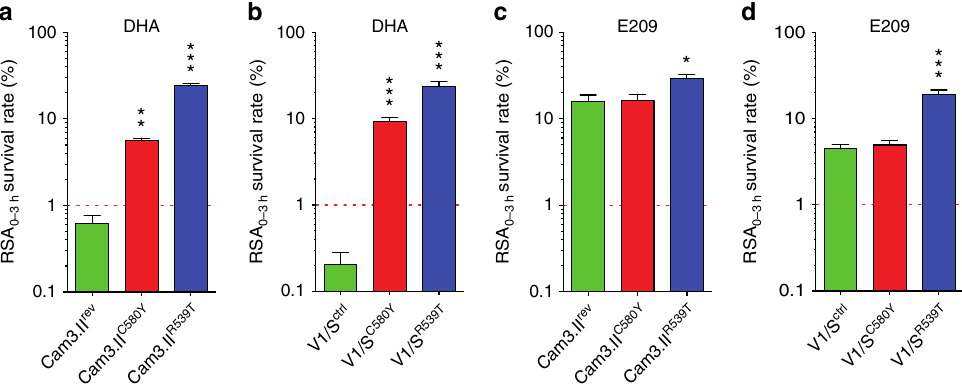
Figure 3 | Ring-stage survival assays show equal potency of E209 against K13 wild-type and C580Y mutant parasites whereas R539T confers a marginal increase of survival. Results show the percentage of early ring-stage parasites (0–3h post-invasion of human erythrocytes) that survived a 6-h pulse of 700nM DHA or E209, as measured by flow cytometry 90hours later. Data show mean ± s.e.m. percentage survival compared to DMSO-treated parasites processed in parallel. Assays were performed on at least 2 separate occasions in duplicate. K13-propeller mutations R539T and C580Y confer resistance to DHA in the clinical isolate Cam3.II and the reference line V1/S ( a ), ( b ). Exposure to E209 reveals generally higher survival with slight cross- resistance observed in parasites carrying the R539T mutation ( c ), ( d ). A two-sample t-test with unequal variances was used to calculate P values. These can be found in Supplementary Tables 7–14. * P value o 0.05, ** P value o 0.001, *** P value o 0.0001.